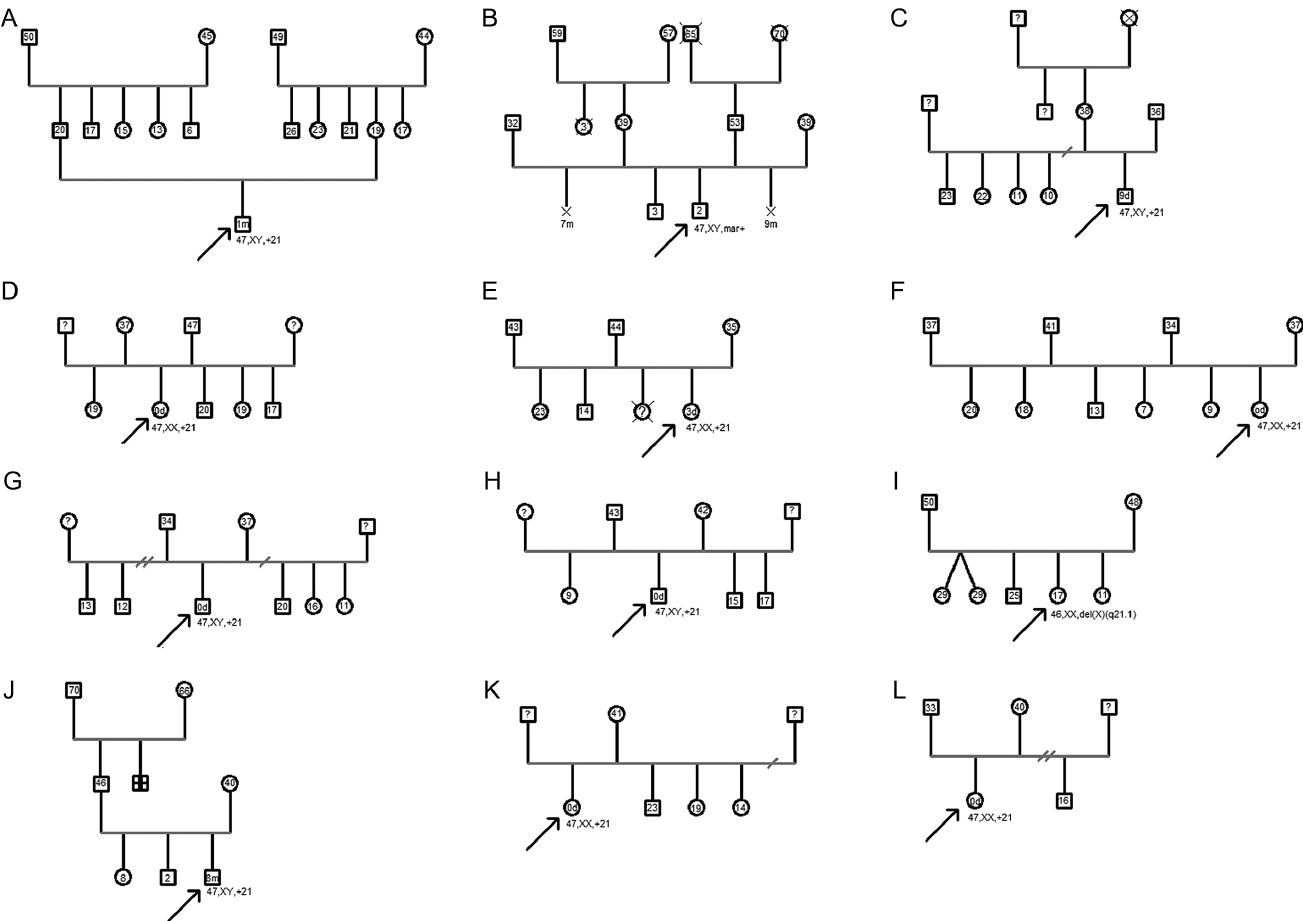
Figure 1. A-L. Main genealogies of 49 children with aneuploidies in Lima, Peru. We have described Down syndrome males (A, C, G, H, J) and females (D, E, F, K, L), with trisomy 13 and other autosomal (B) and sexual aberrations (I). In each case, family tree does not cover more than 2 degrees of consanguinity; evaluators did not include other relevant epidemiological data from the history of the patients. In a single case, detailed information is shown (A). The purpose of the study is indicated by black arrows. Software: GenoPro v3.0 (GenoPro Inc, York, Maine.,